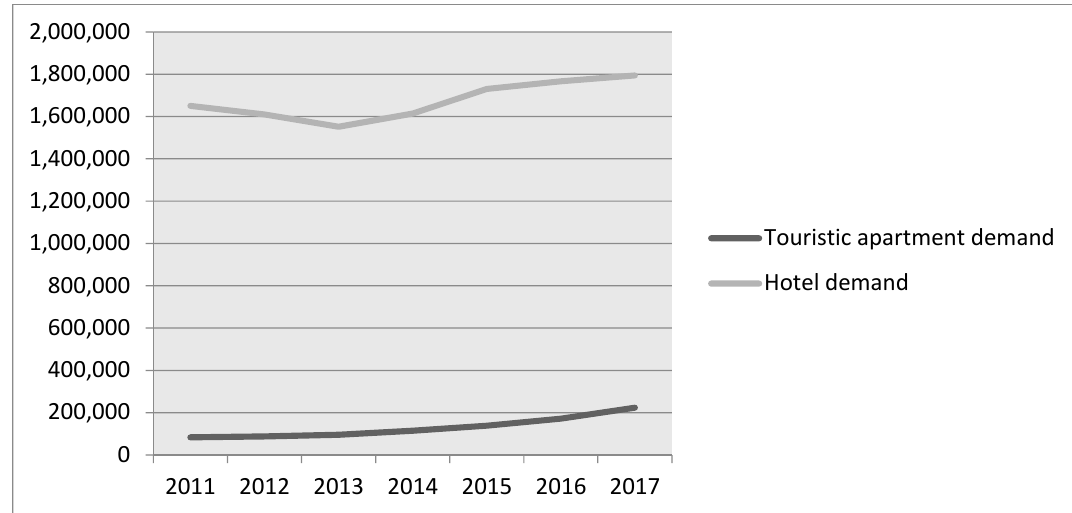
Figure 3. Tourist apartments listed in Airbnb in Valencia. Source: Airdna (2018).